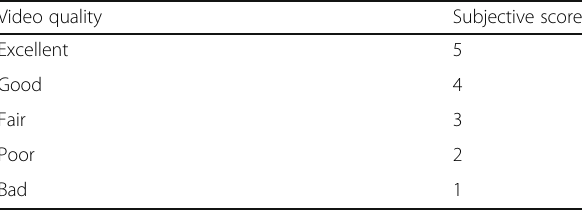
Table 9 Subjective scoring criteria Video quality Subjective